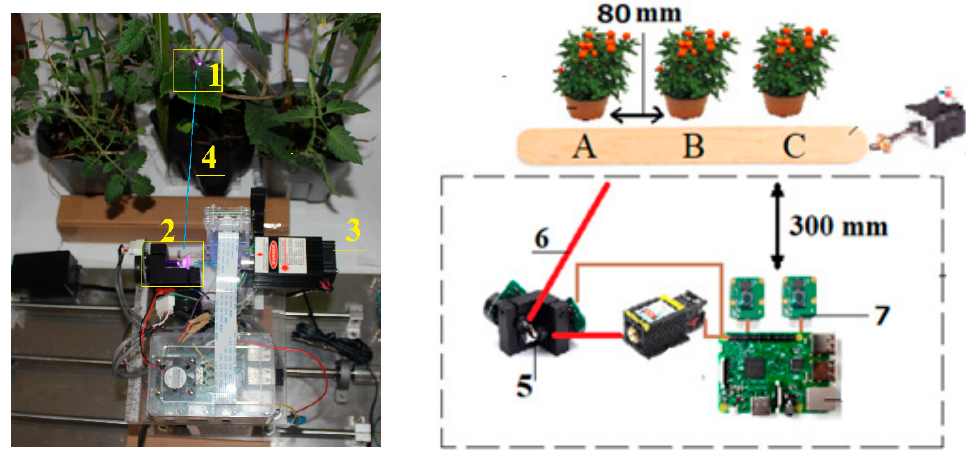
Figure 10. The experimental set up. 1. Focusing the laser beam; 2. mirrors from the galvanometer; 3. the laser; 4. laser beam; 5. galvanometer; 6. schematic image of the laser beam; 7. cameras.